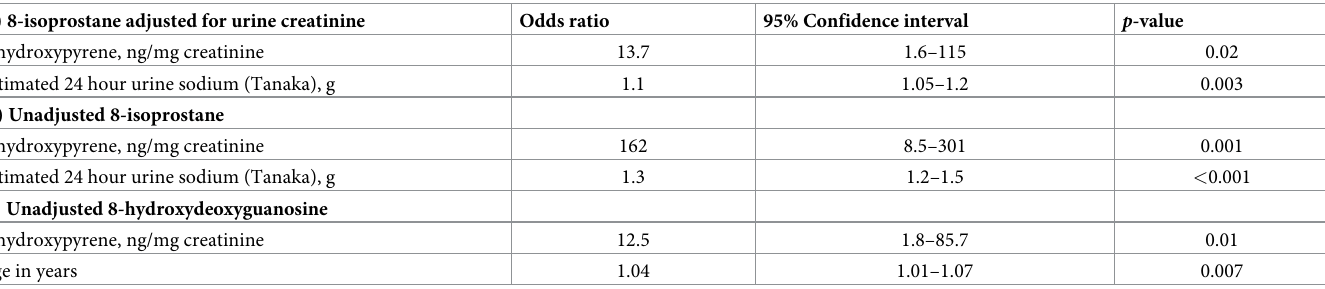
Table 2. Logistic regression for adjusted (a) and unadjusted (b) urinary 8-isoprostane dichotomized at the